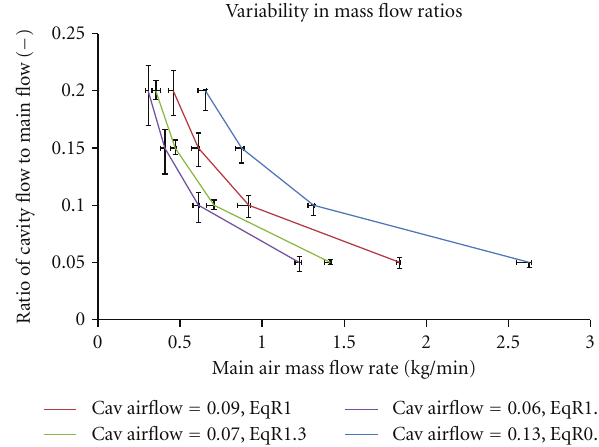
Figure 10: Variability in air mass flow rate combinations yielding di ff erent equivalence